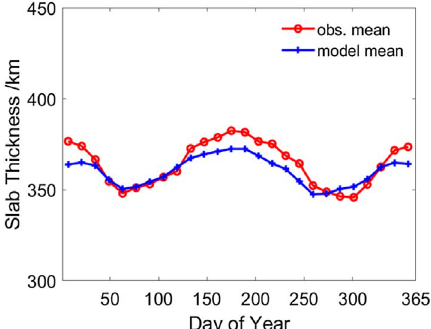
Fig. 1. Overall variation of the equivalent slab thickness as a function of the local time (solid red line) in comparison with model values (dashed blue line).